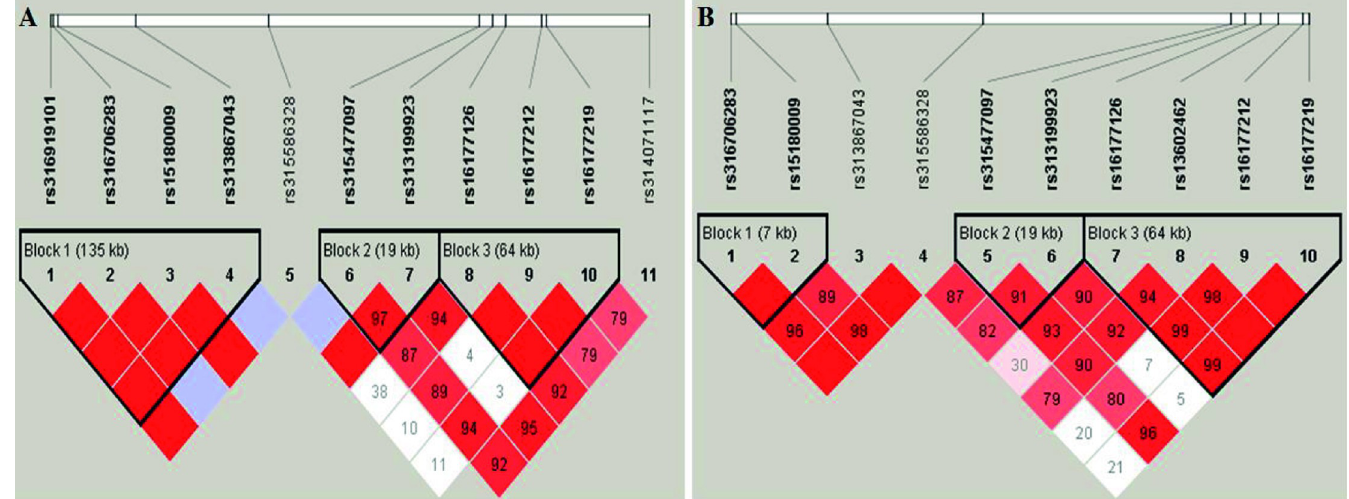
Fig 2. The haplotype blocks and linkage disequilibrium. (A) the N146 population, (B) the N280 population. The darker shading indicates higher linkage disequilibrium and the number within rhombus was D’ value.